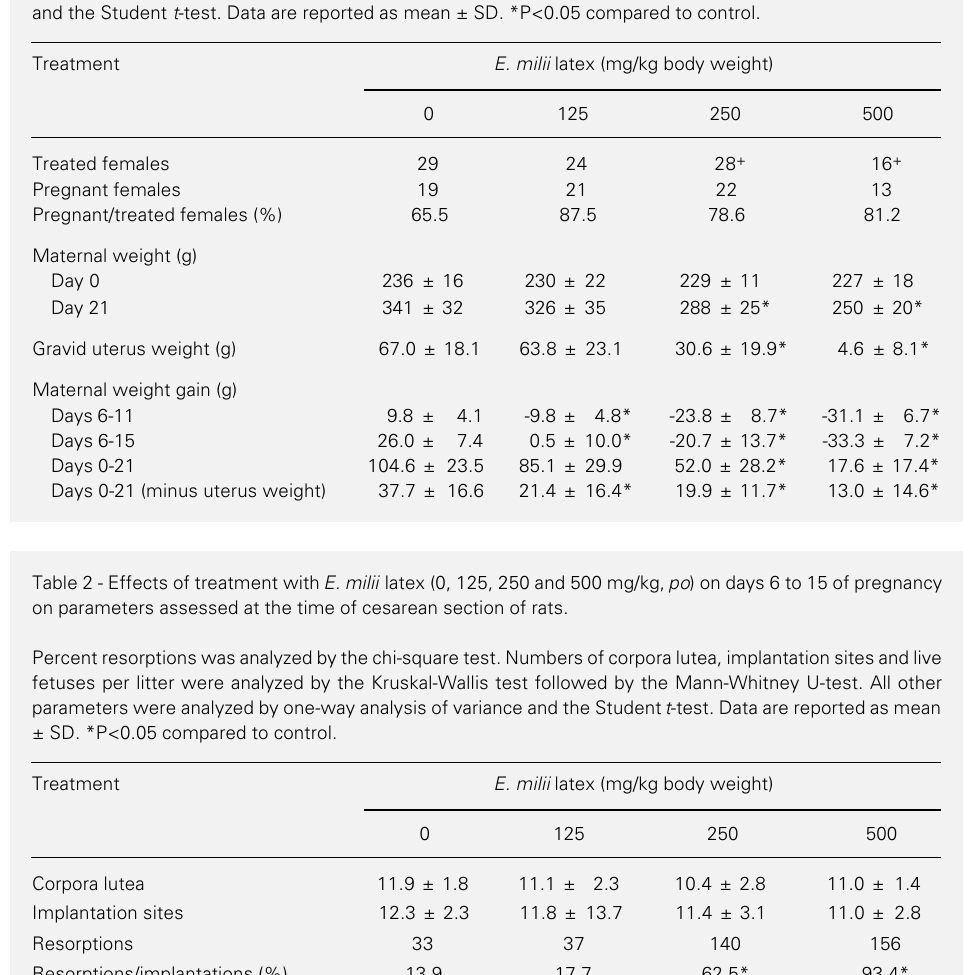
Table 1 - Maternal weight gain of rats treated orally with Euphorbia milii latex (0, 125, 250 and 500 mg/kg, po ) on days 6 to 15 of pregnancy. + Two rats treated with 500 mg/kg and one treated with 250 mg/kg died and were not included. % of pregnant females was analyzed by the chi-square test. Maternal weight gain was analyzed by the Kruskal-Wallis test followed by the Mann-Whitney U-test. All other parameters were analyzed by one-way analysis of variance and the Student t -test. Data are reported as mean ± SD. *P<0.05 compared to control.